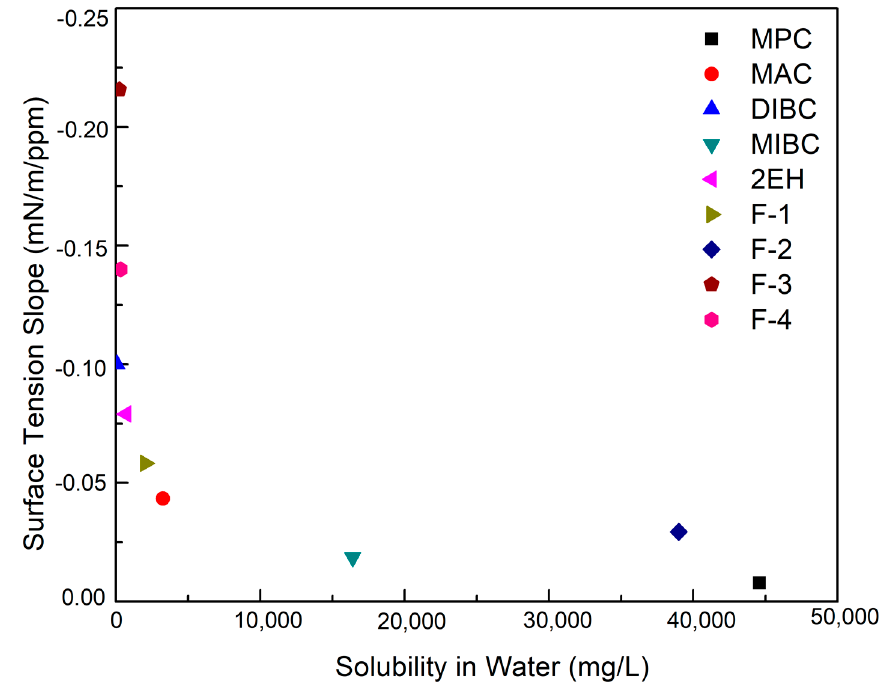
Figure 3. Surface tension reduction ability of the nine evaluated frothers as a function of water solubility.